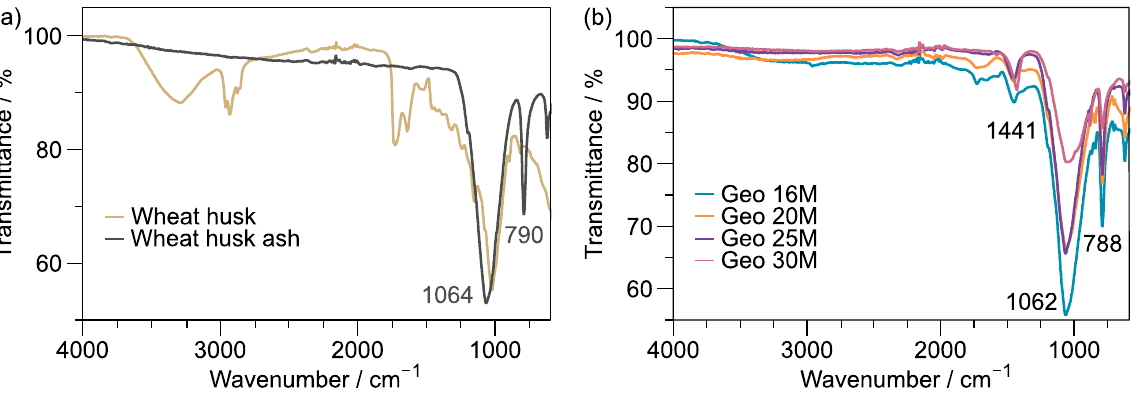
Figure 2. FT-IR spectra of the wheat husk (WH), WHA, and formulations of Geo 16M to Geo 30M: ( a ) WH, WHA; ( b ) Geo 16M, Geo 20M, Geo 25M, and Geo 30M.